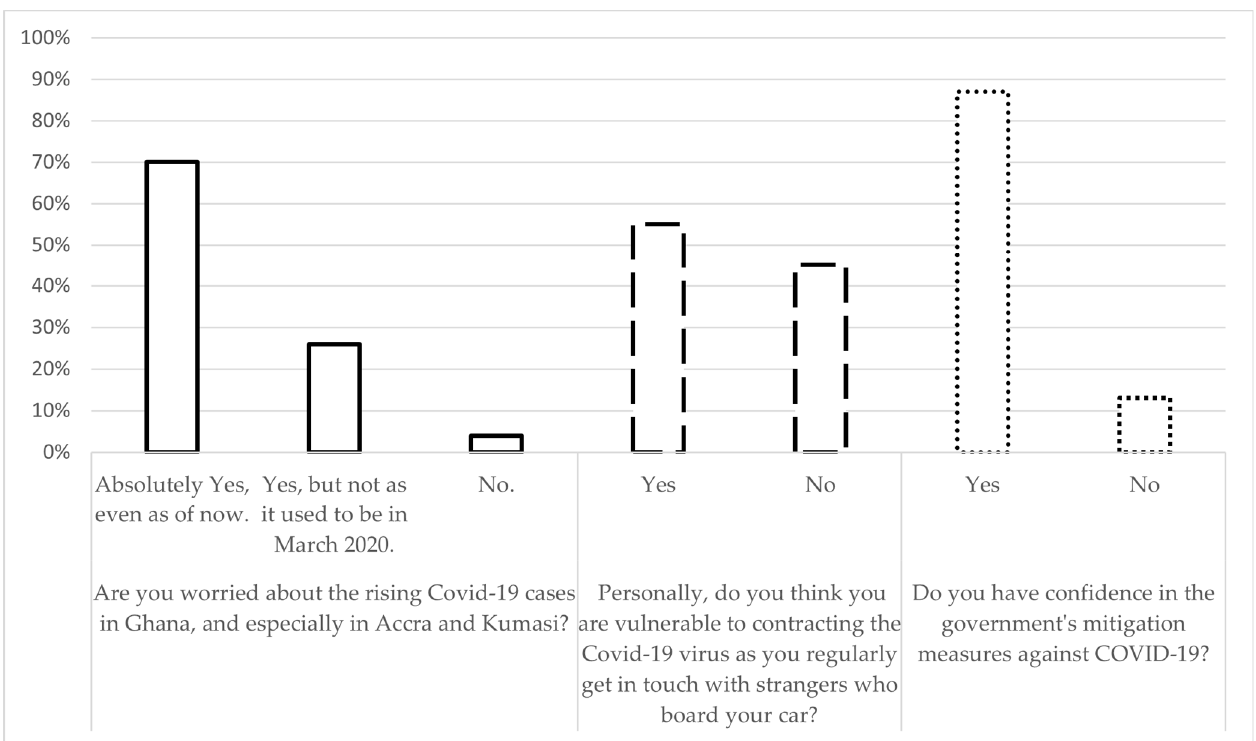
Figure 3. Attitudes of participants regarding COVID-19 (N = 1014).